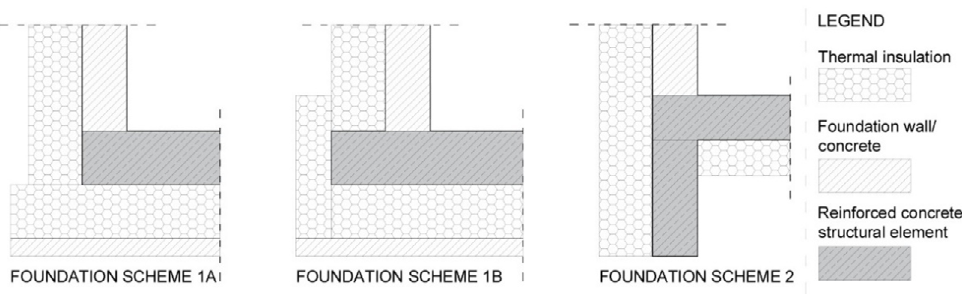
Figure 7. Schemes of the most common solutions of joint of the slab-on-ground foundation and external wall in PH.